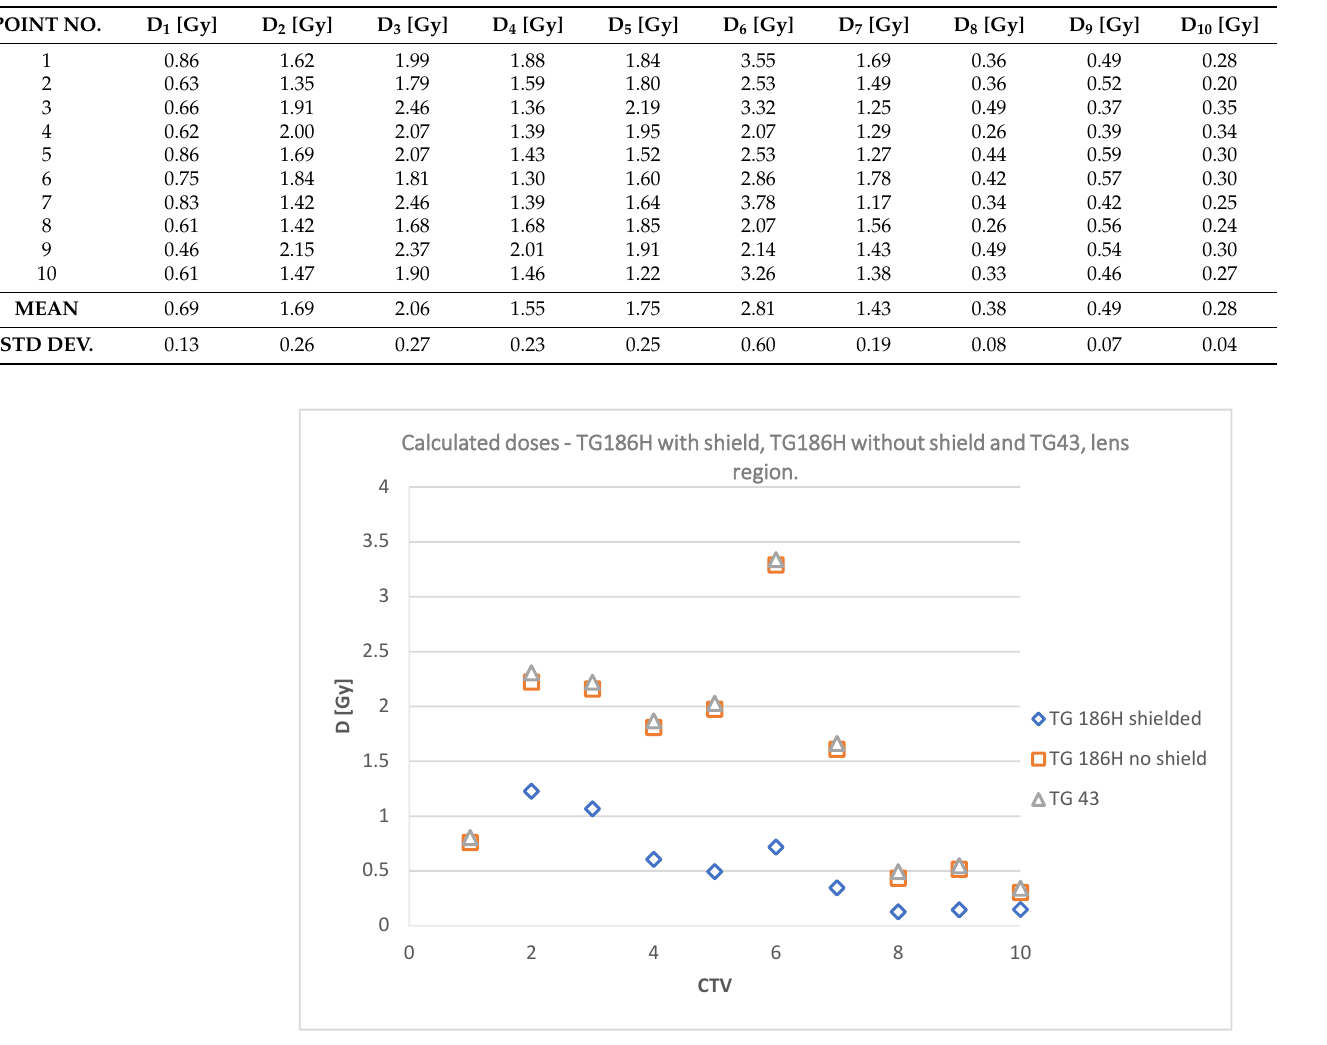
Table 6. Doses measured at a point in the lens of the eye without a lead shield.